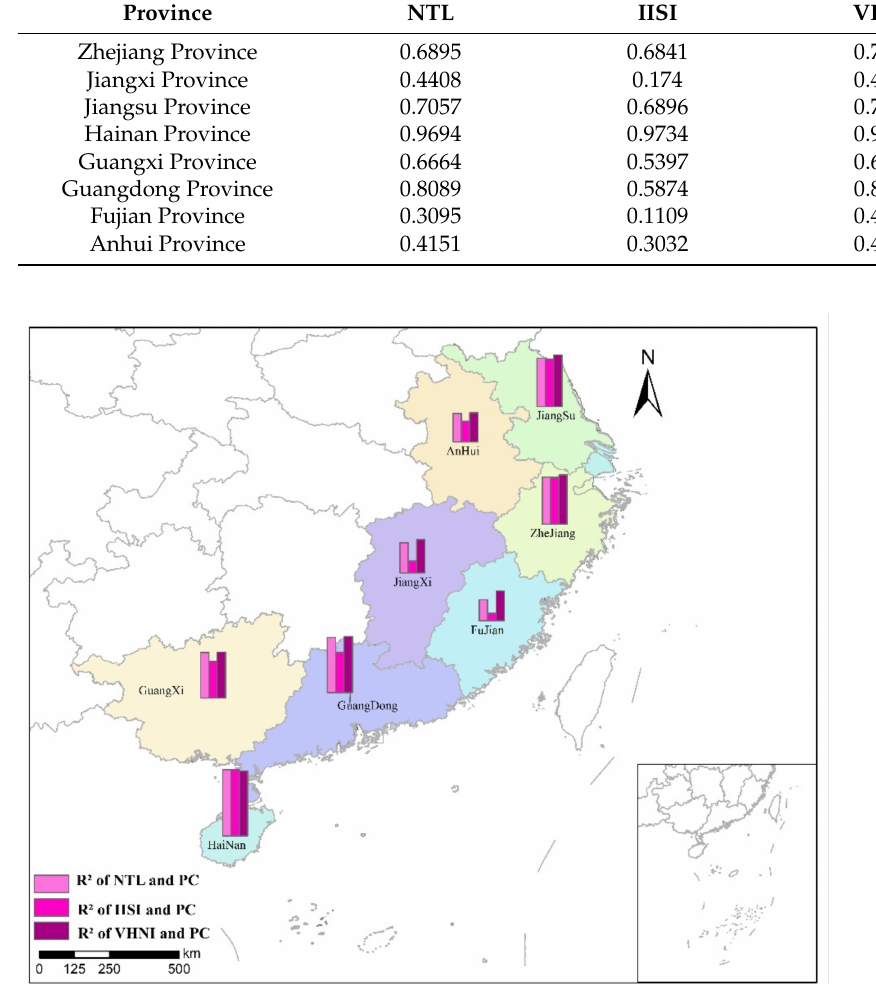
Figure 13. R 2 spatial distribution of TNL and power consumption linear